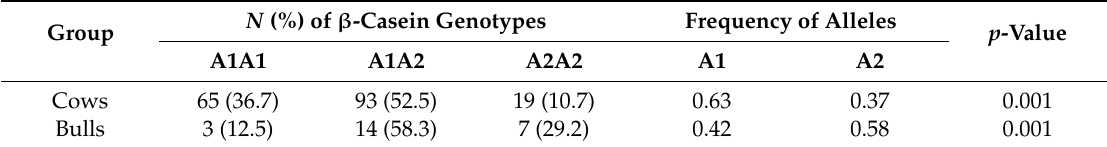
Table 1. Genotype and allele frequency of β -casein in Polish Red cows and bulls. N (%) of β -Casein Genotypes Group